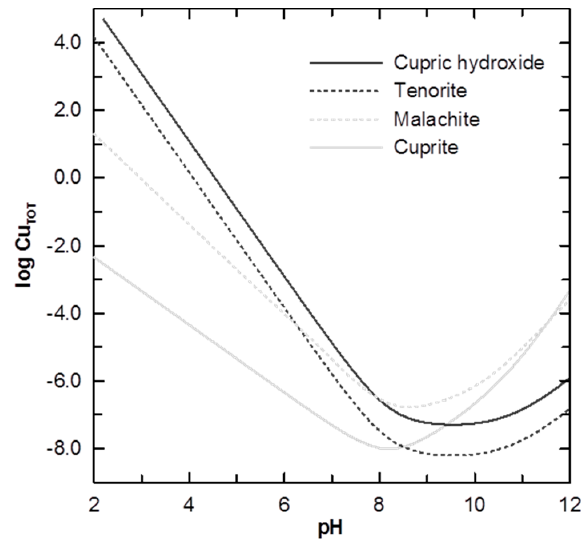
Figure 4. Example of hindered interpretation of copper solubility owing to copper nanoparticles measured as dissolved copper. Cupric hydroxide dominates solubility at pH 7. However, if copper nanoparticles are contributing with as low as ~0.01 mM (measured as dissolved copper), then control over copper solubility can shift from cupric hydroxide to either malachite or tenorite. Calculations made considering CO 3 TOTAL = 10 − 5 M, E ◦ = 0.18